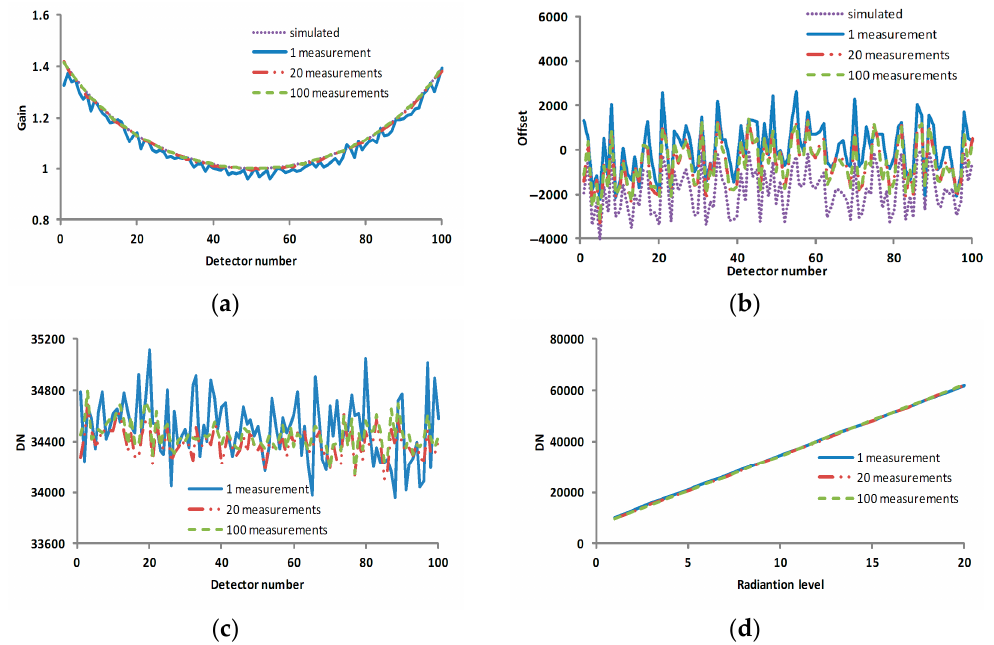
Figure 7. The profiles of the calibration coefficients and corrected results in various cases. ( a ) the gain coefficient in various scenarios; ( b ) the offset coefficient in various scenarios; ( c ) the profile of line 10 in the corrected result corresponding to Figure 4c; and ( d ) the profile of column 50 in the corrected result corresponding to Figure 4d. The horizontal axes of ( a – c ) are the pixel number, and the vertical axes of ( a – c ) are the gain coefficient, offset coefficient and DN, respectively. The horizontal axis and vertical axis of ( d ) are the radiation level and DN, respectively.